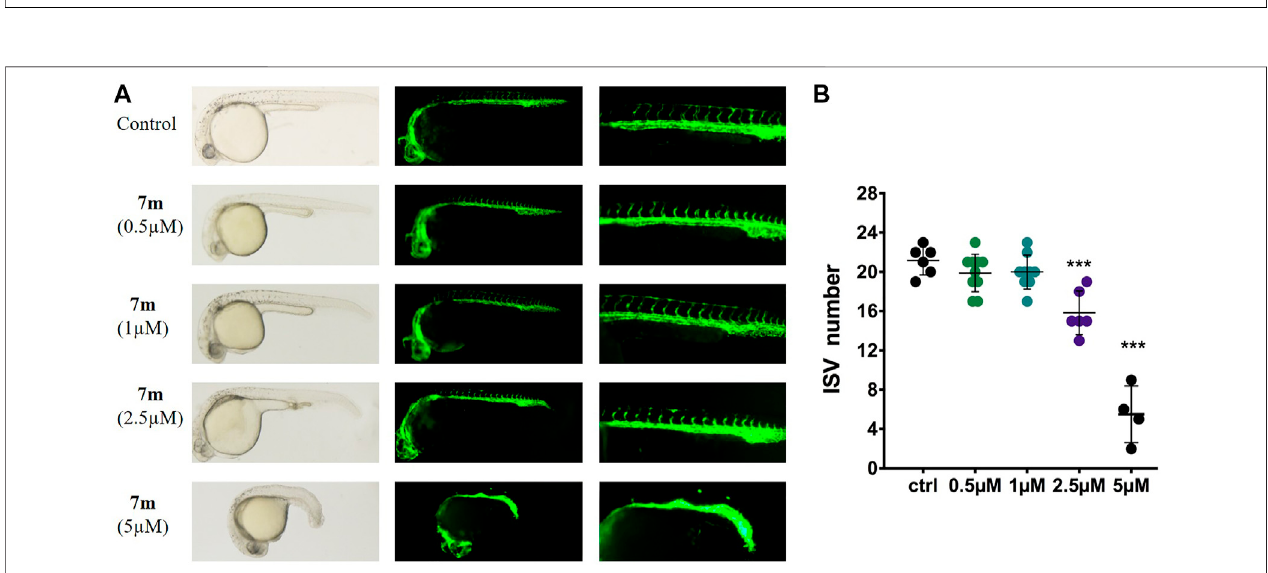
FIGURE 10 | Anti-angiogenic effects of 7m in zebra fi sh embryos. (A) Zebra fi sh embryos were incubated with the tested compounds at 0.5, 1, 2.5, and 5 µM. The left angiogenic vessels were magni fi ed and shown in the right section. (B) Histogram showed the numbers of zebra fi sh intersegmental vessels (ISVs) per fi eld under confocal microscopy. Results represented the means ± SD. ** p < 0.01; *** p < 0.001 compared with untreated control.